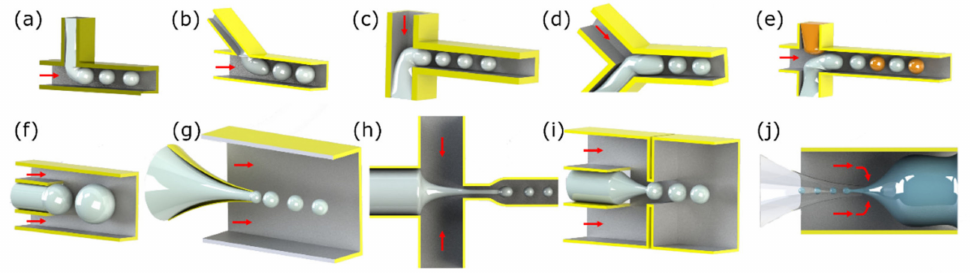
Figure 4. Schematics of various droplet-based microfluidic designs used in various works, including ( a – e ) the cross-flow, ( f , g ) the co-flow, and ( h – j ) the flow-focusing, are shown. Here the fluid in blue color stands for the magnetic materials used for creating the magnetic particles, and the red arrows depict the direction of the continuous phase flow. In ( e ), two dispersed phases form (blue and